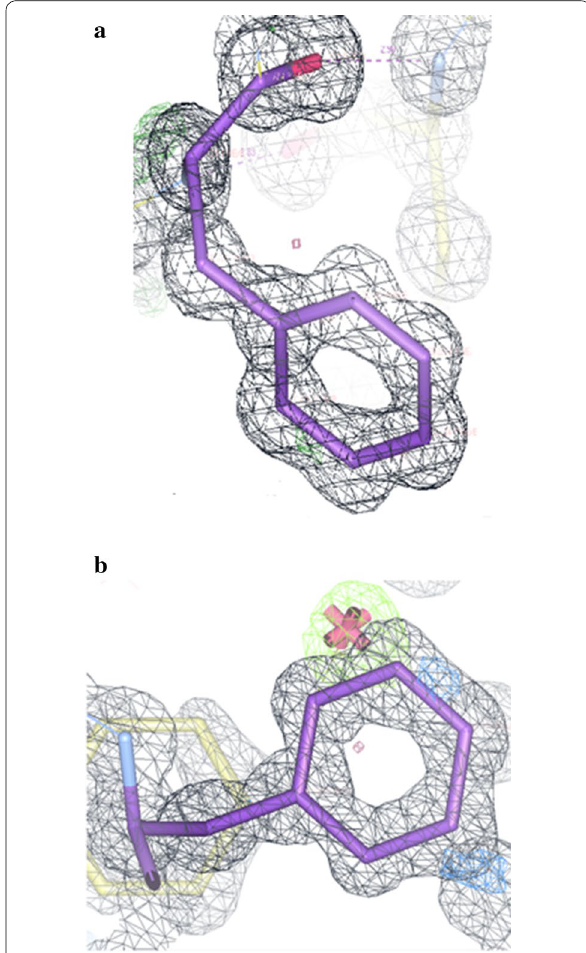
Fig. 28 a Electron density in the Intergen (II) structure for PheB24, an example of a clear single highly resolved amino acid residue as in Insugen (I), Fig. 27a. b Electron density in the Intergen (II) structure for PheB25. Unlike PheB25 in Insugen (I), Fig. 27b which has very weak electron density, this is another example of a clear single highly resolved amino acid residue as in Insugen (I) PheB24, Fig. 27a and Intergen (II) Phe24, ( a